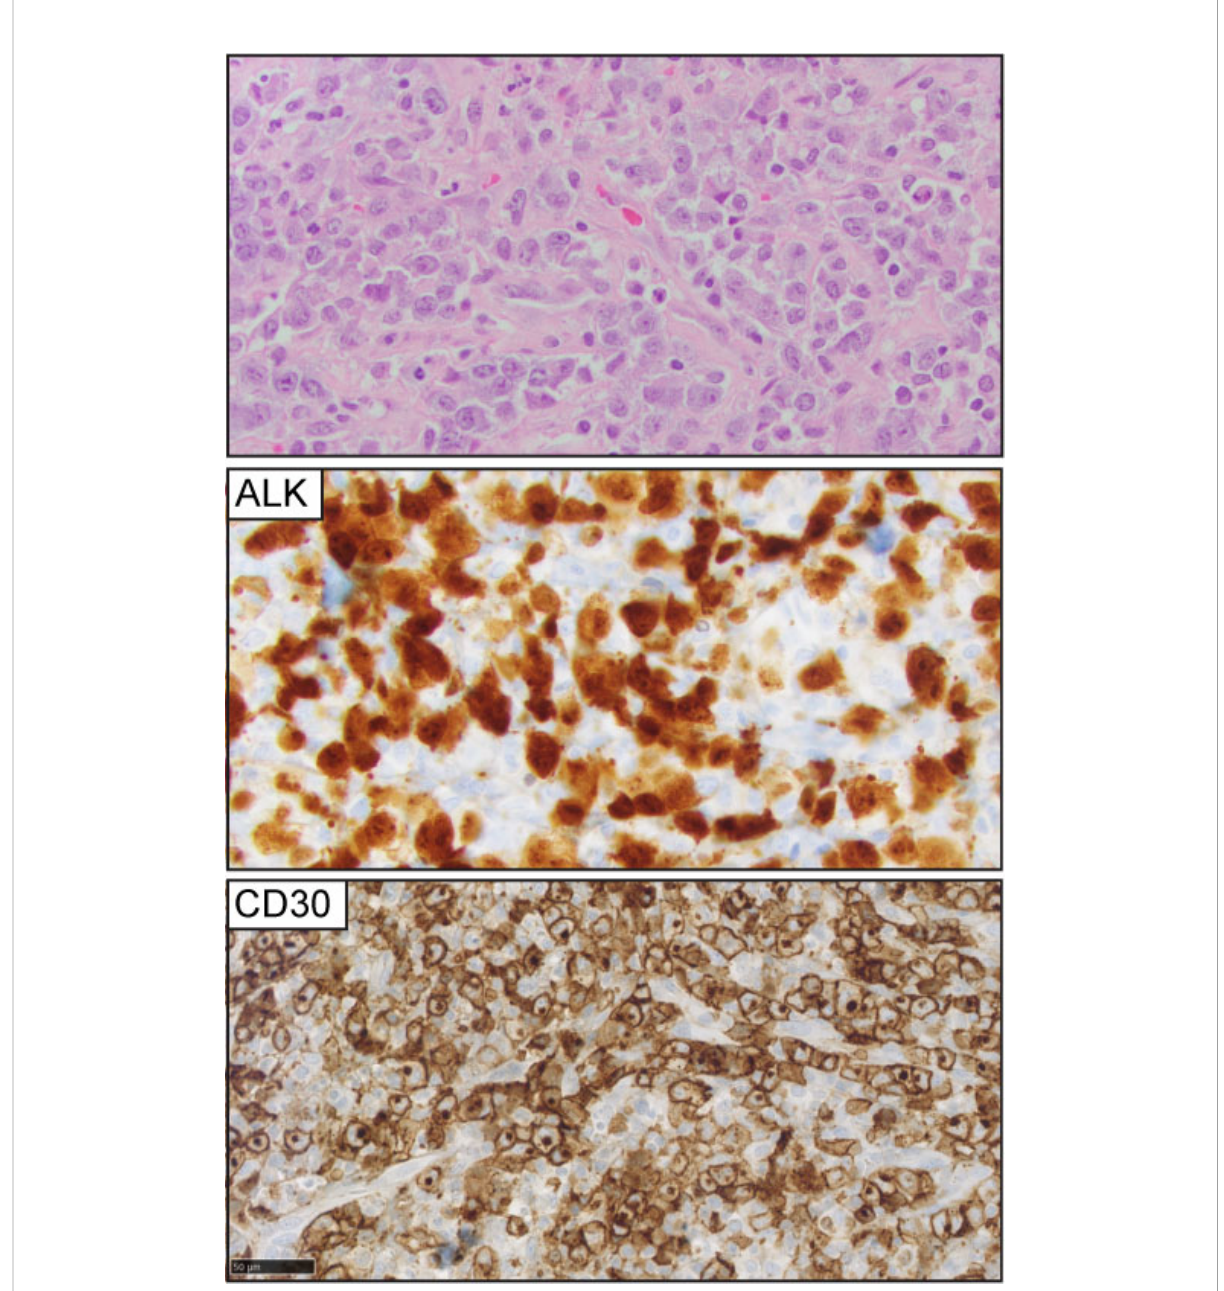
FIGURE 4 Anaplastic large cell lymphoma (ALCL). Representative (H&E) pictures of ALCL highlight the clustering of large, atypical lymphocytes with a variable amount of cytoplasm, open chromatin, and ‘ kidney-shaped ’ nuclei. ALK expression is detected in 50% of the cases (ALK+ ALCL). CD30 expression is homogeneously positive in at least 80% of the tumor